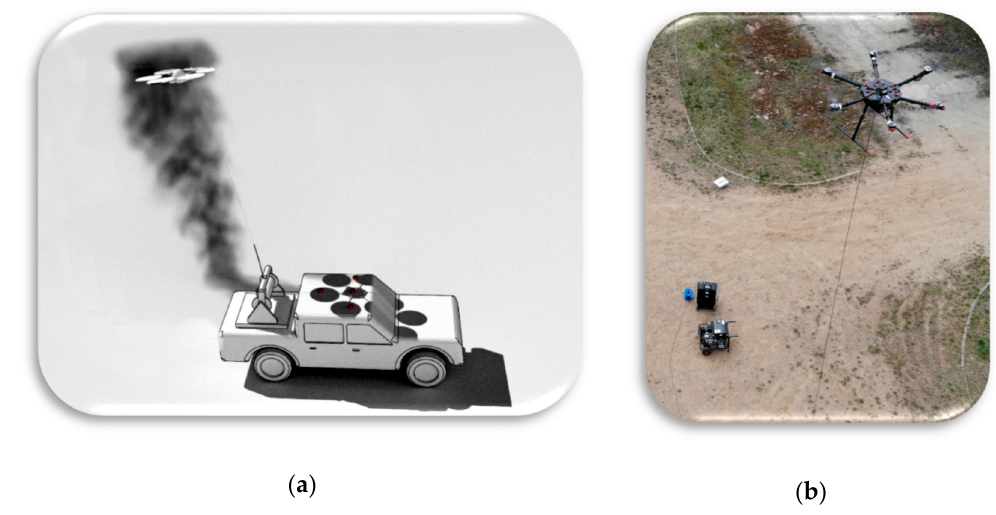
Figure 1. Visualization of the platform during toxic gases measurements ( a ) and a view of the power system of the drone ( b